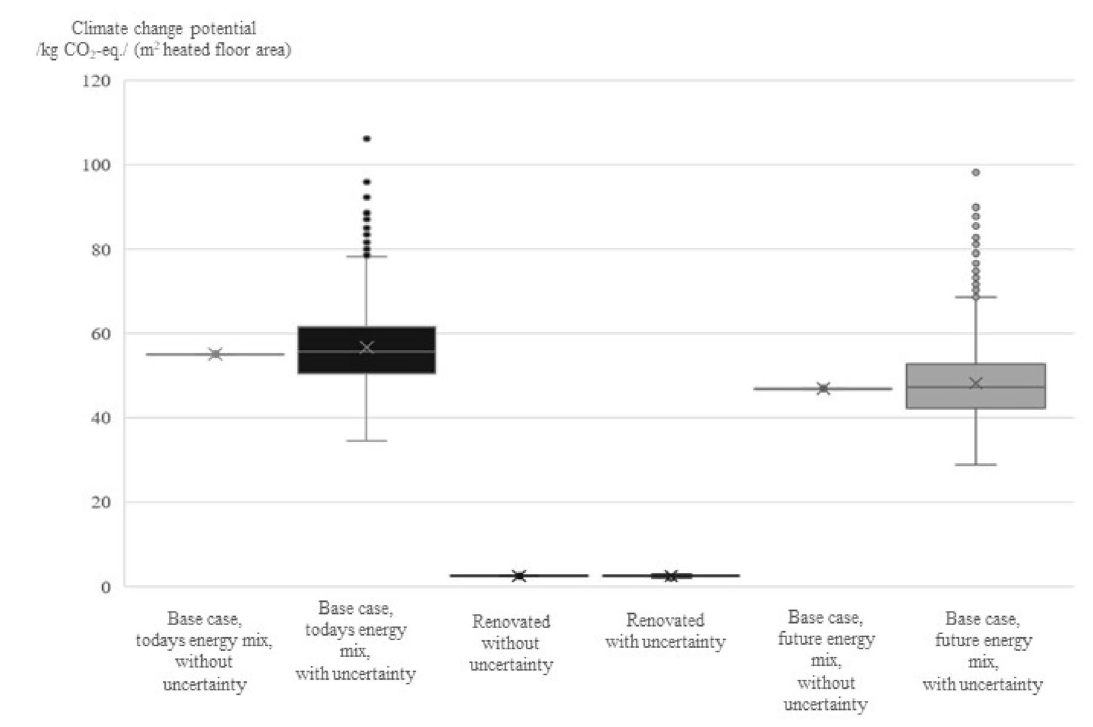
Fig. 7 Simulation results for the climate change potential due to the replacement the windows on the ground and first floors. Results are shown with and without consideration of uncertainties in the input data and with two different scenarios for the energy mix